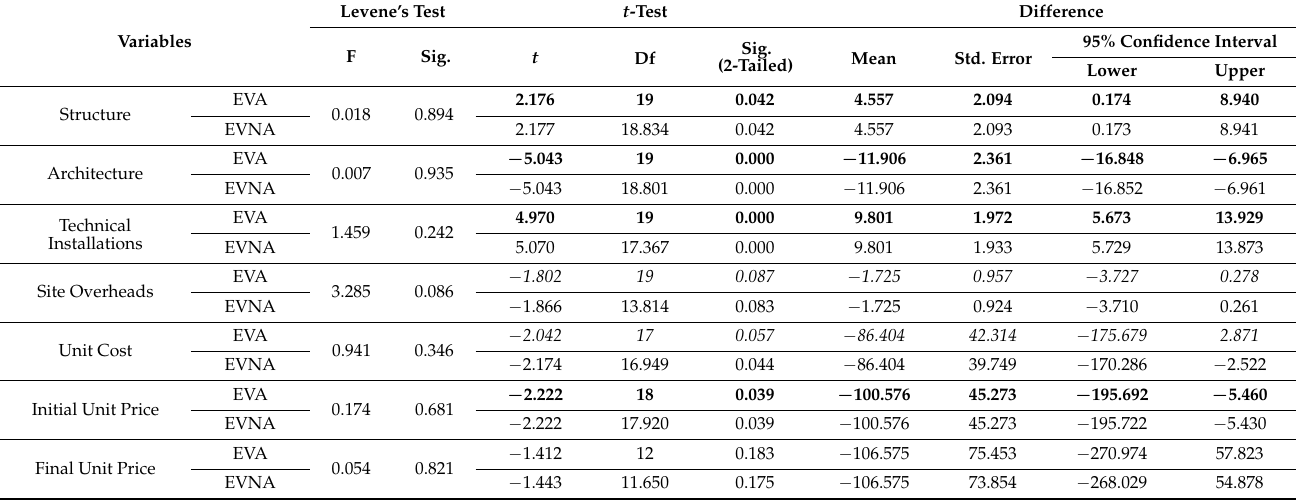
Table 3. Means comparison between residential and office buildings’ cost categories weights and unit cost and prices. Variables